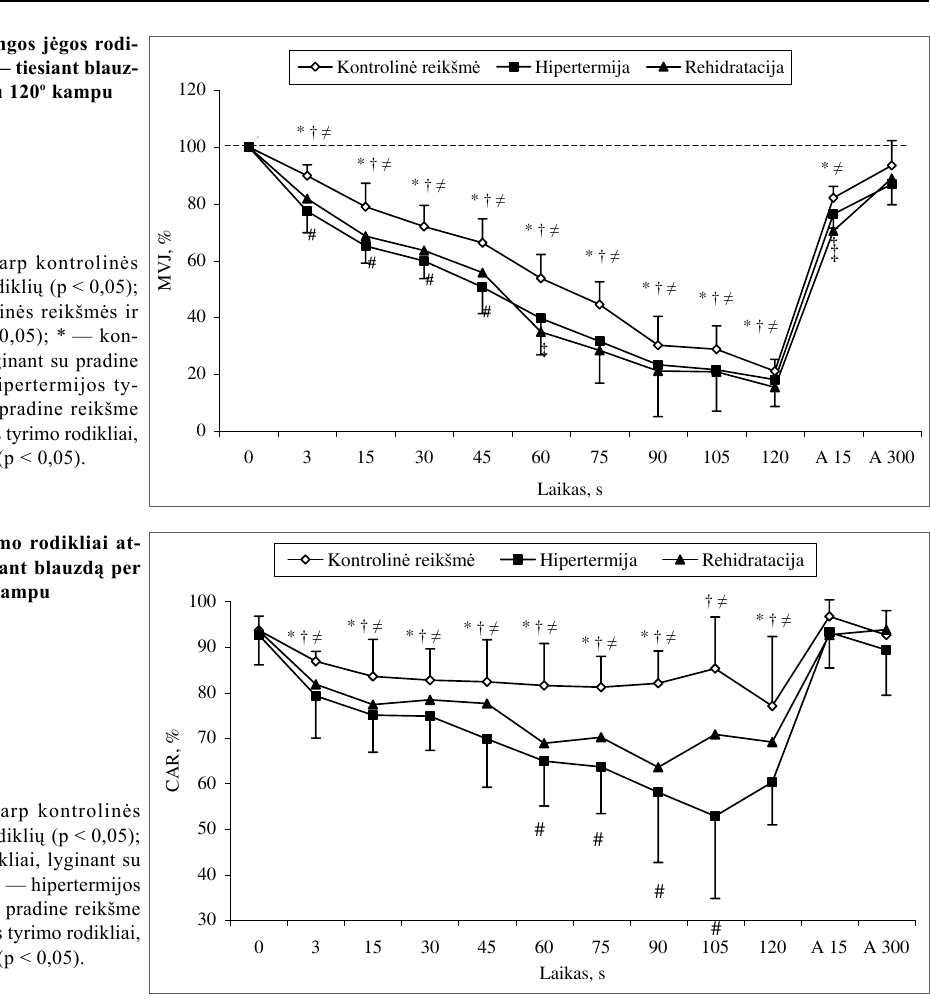
‡ — skirtumas tarp kontrolin ė s reikšm ė s ir rehidratacijos rodikli ų (p < 0,05); * — kon- trolinio tyrimo rodikliai, lyginant su pradine reikšme (p < 0,05); ≠ — hipertermijos ty- rimo rodikliai, lyginant su pradine reikšme (p < 0,05); † — rehidratacijos tyrimo rodikliai, lyginant su pradine reikšme (p < 0,05).